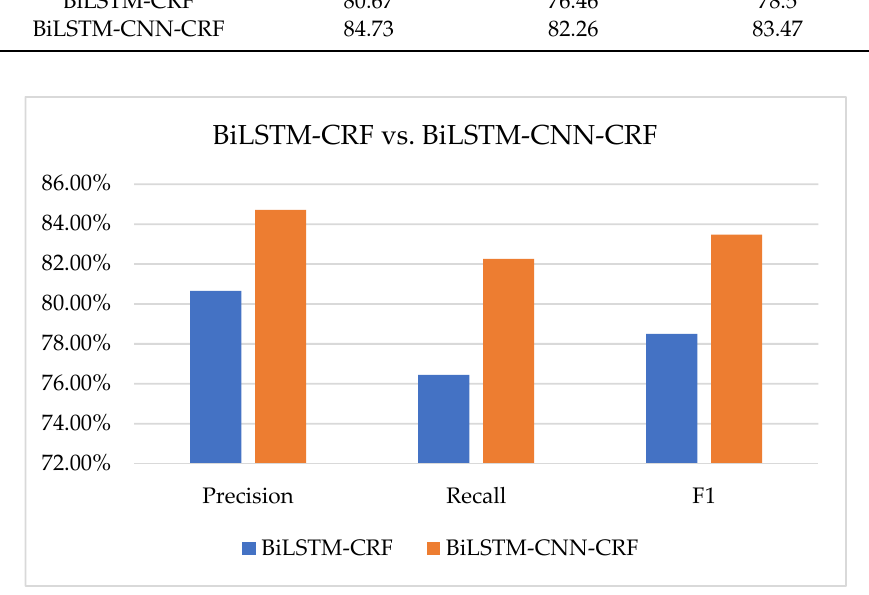
Figure 11. Histogram of BiLSTM-CRF and BiLSTM-CNN-CRF.